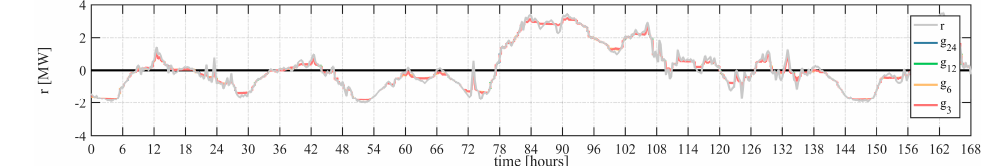
Figure 12. Residual and grid power profiles achieved by OPEM over a generic week by employing different time horizons.